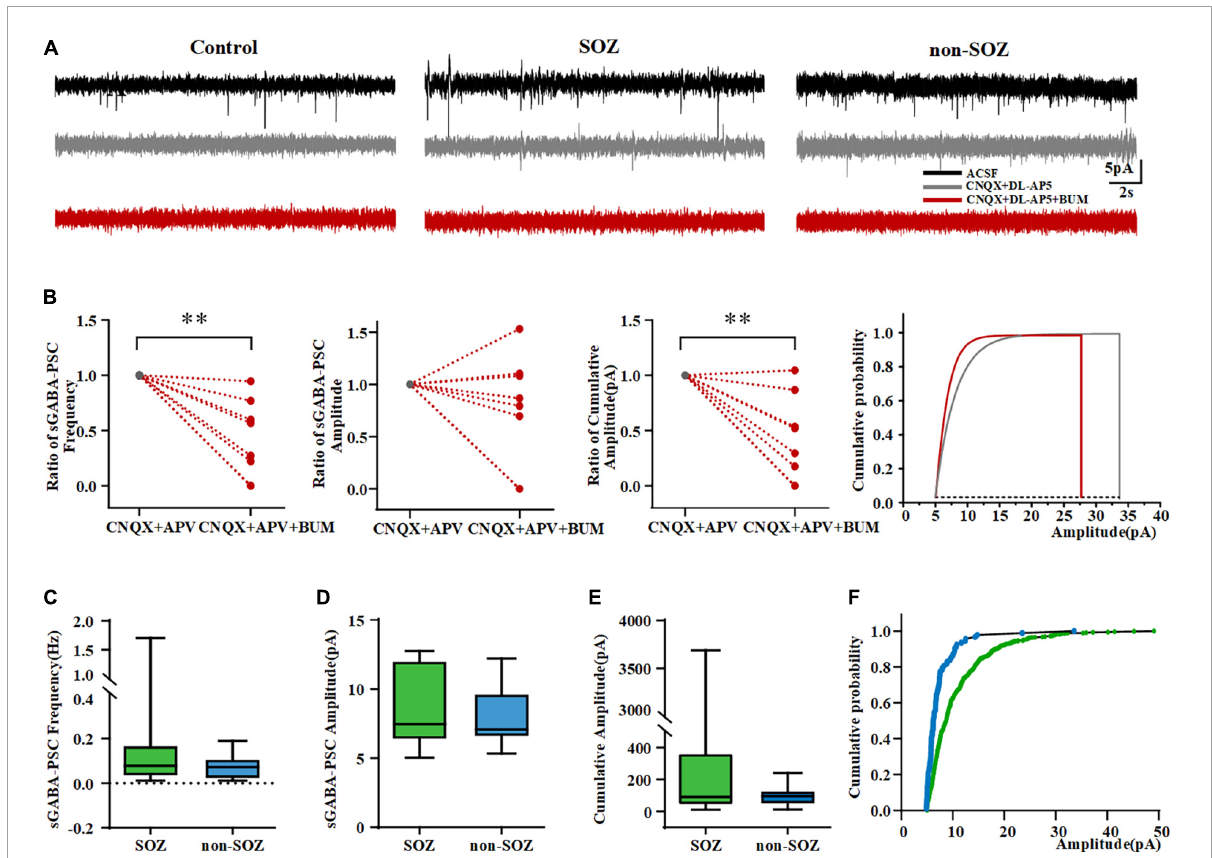
FIGURE3 Pyramidal neurons in the SOZ and non-SOZ of focal cortical dysplasia (FCD) showing depolarizing bumetanide-sensitive GABA A receptor responses. (A) Altered inhibitory GABAergic signaling in SOZ and non-SOZ groups. (B) Bumetanide significantly dampened the frequency and cumulative amplitude of GABA A R-mediated sPSCs in FCD patients N = 10. (C–E) GABA A R-mediated sPSCs are shown in the SOZ and non-SOZ groups. (F) Cumulative GABA A R-mediated sPSCs amplitude probability distributions for pyramidal neurons from SOZ and non-SOZ groups. ∗∗ p < 0.01. Data was shown as medians and interquartile range